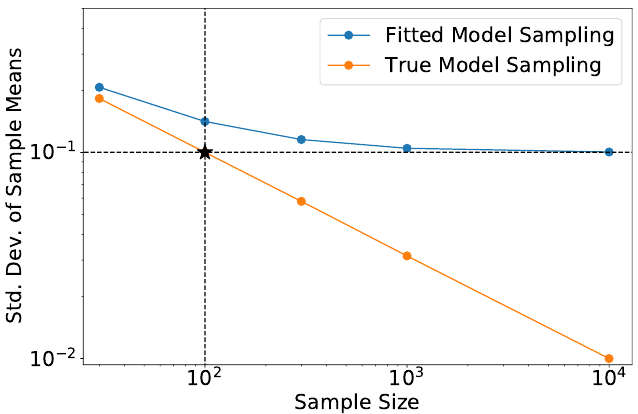
Figure 6: Evolution of the standard deviation of the sample means with respect to the sample size. The orange line corresponds to the case where events are sampled from the true distribution as in the left panel of Figure 5. The blue line corresponds to the case from the right panel of Figure 5, where events are generated from f fitted to n = 100 events sampled from the true